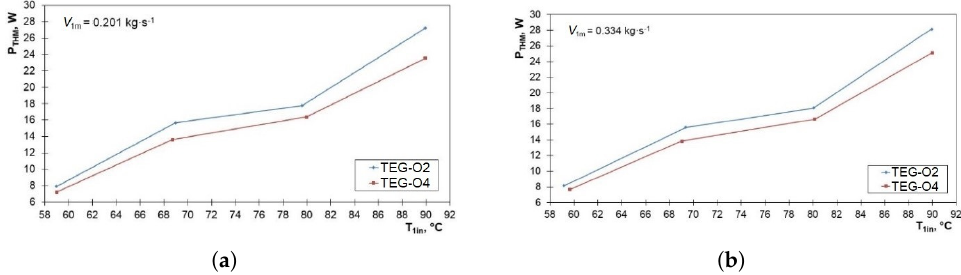
Figure 16. Characteristics of the power generated by the TEG set in relation to T 1 in at the minimum and maximum flow rate V 1 m for the selected HSHE fluid circulations: ( a ) V 1 m = 0.201 kg · s − 1 ; ( b ) V 1 m = 0.334 kg · s − 1